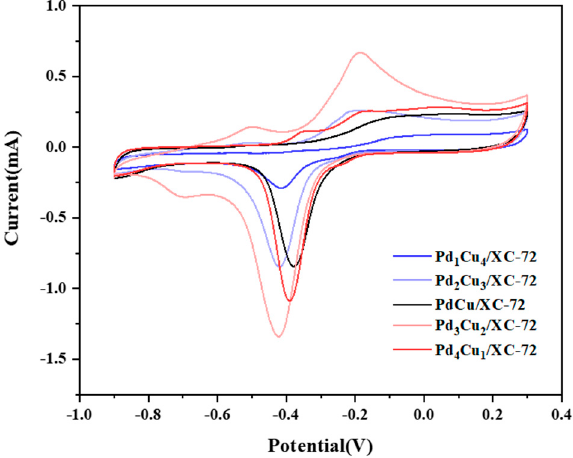
Figure 7. CVs in 1.0 M KOH + CH 3 OH-purged N 2 at 50 mVs − 1.